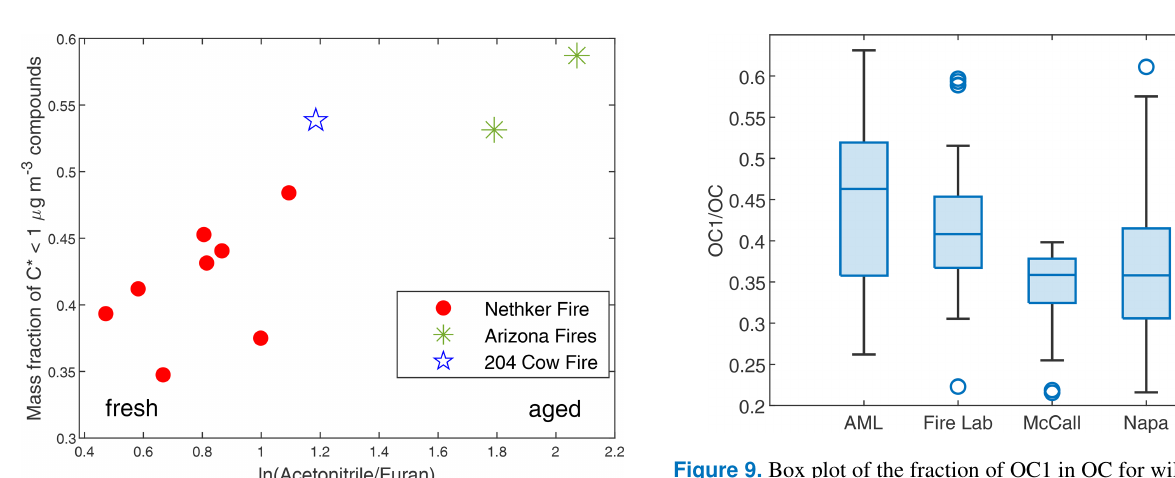
Figure 9. Box plot of the fraction of OC1 in OC for wildfire emis- sions. Each box plot shows the interquartile range with whiskers extended to 1.5 times the interquartile range. Central marks are the medians. Circles denote